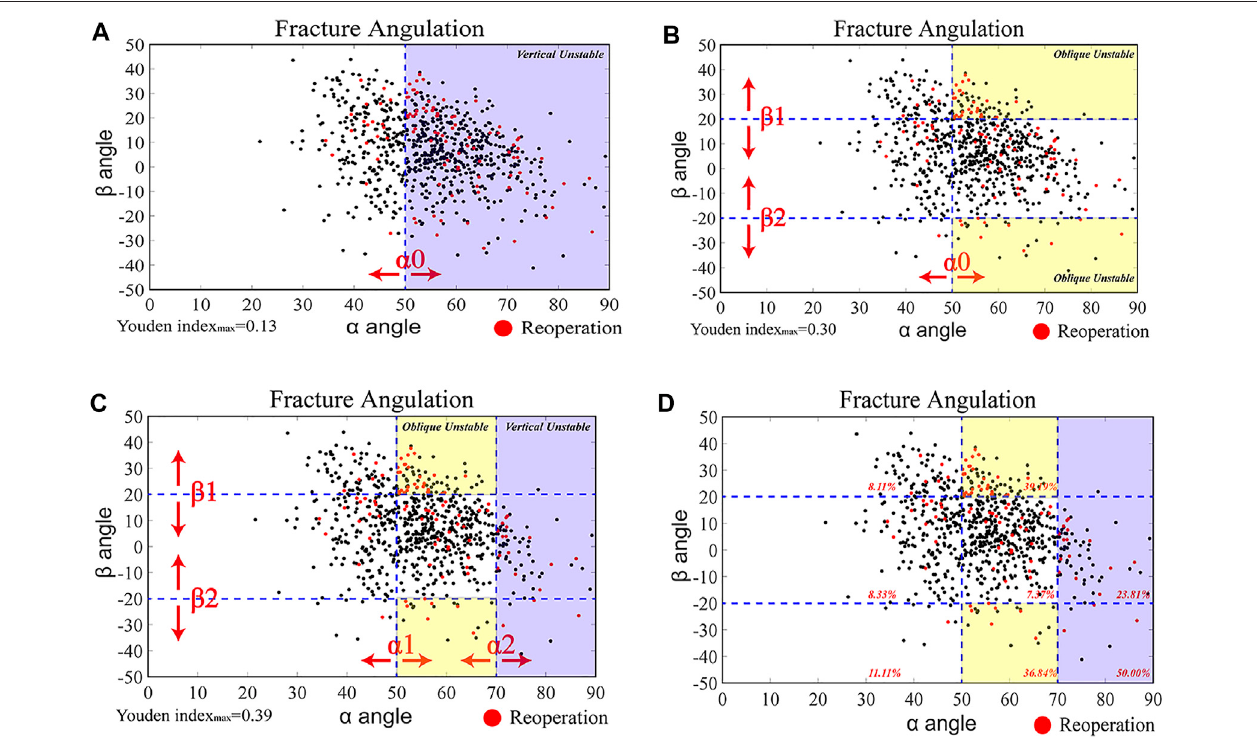
FIGURE 3 | Identi fi cation of Three-Dimensional Unstable Inclination angles based on clinical prognosis analyses (A – C) Scatterplots of 3-D inclination angles of all FNFs ( n (cid:1) 755) (black dots). Reoperated cases (red dots) are overlaid. The identi fi cation of 3-D unstable inclination angles was based on the 755 reoperation cases ( n (cid:1) 100; See Supplementary Table S2 ) and their associated α and β angles calculated from the 3-D reconstructions of their proximal femur and FNFs. Three grouping principles were tested in the diagnostic test: (1) vertical unstable [ (A) , purple-colored region); (2) oblique unstable [ (B) , yellow-colored region]; and (3) both vertical and oblique unstable [ (C) , purple-colored and yellow-colored regions]. (D) The optimal threshold values ( α 0, α 1, α 2, β 1, β 2) were identi fi ed by calculating the maximum Youden index among over 12,160 possible combinations. The combined vertical ( α > 70 ° ) and oblique (50 ° < α < 70 ° and β > 20 ° / < − 20 ° ) unstable types had the highest Youden index (0.39). The reoperation rate percentages (red) are shown in each